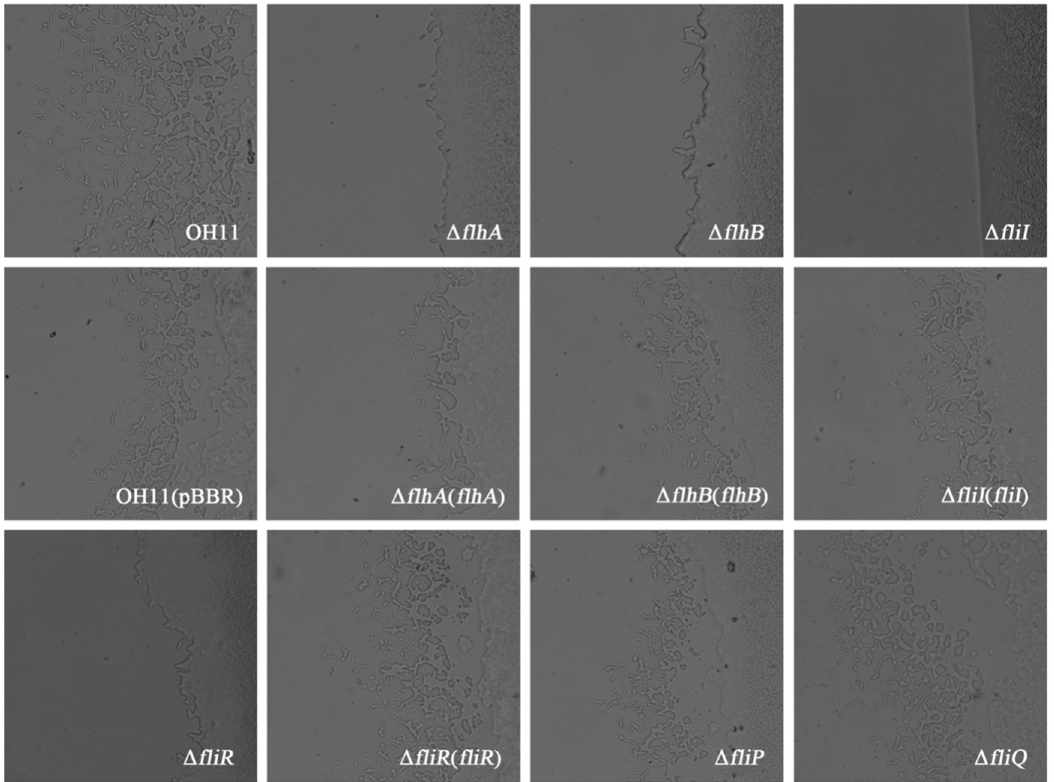
Figure 2. Involvement of the FT3SS genes in twitching motility in L. enzymognes OH11. In 1 / 10 tryptic soy broth (TSB) agar medium, wild-type OH11 exhibit twitching motility, as evidenced by the appearance of mobile cells at the colony margin, while the mutant strains, including ∆ flhA , ∆ fllhB , ∆ fliI , and ∆ fliR reveal no such capability. Complementing plasmid-borne flhA , flhB , fliI , or fliR gene back to each respective mutant rescued twitching motility. However, the ∆ fliP and ∆ fliQ mutants still show wild-type twitching motility.